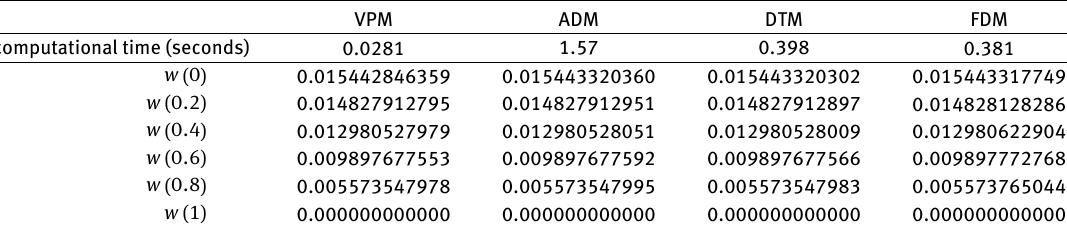
Table 4: Comparison of the required computational time to solve (40) and solutions at six data points